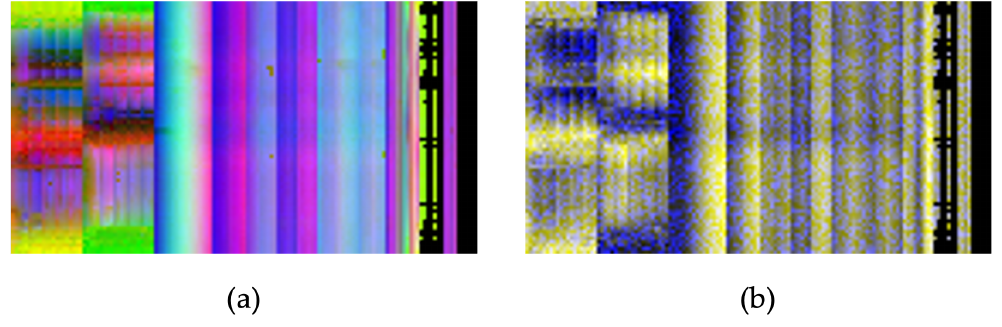
Figure 6. Images generated by the proposed method (word: burn); ( a ) the result of the normalization process; ( b ) the result of the standardization